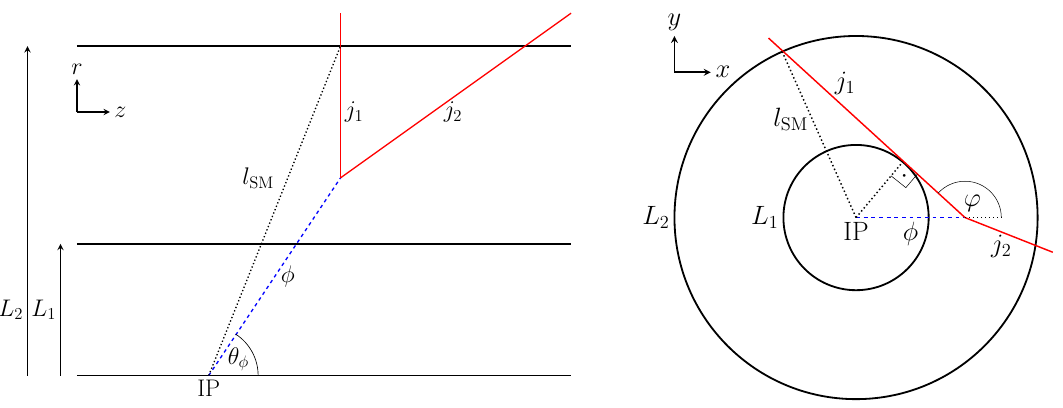
Figure 11 . Sketch of the geometry in the longitudinal (left) and transverse (right) plane. Without loss of generality we show the case ϕ